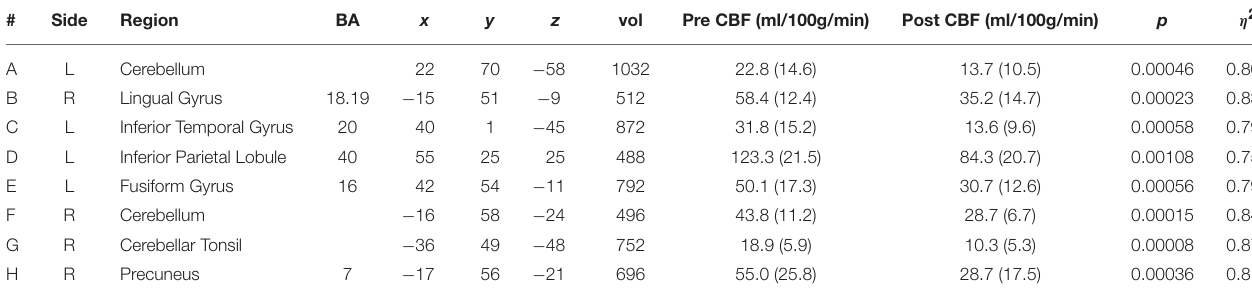
P-values and effect sizes reflect the change from baseline (pre) to after detraining (post) based on the average CBF within each ROI at each time point. η 2 , partial eta squared (effect size); # corresponds with regions shown in Figure 1 ; BA, Broadmann areas; LPI coordinates, positive, left (x), posterior (y), inferior (z); vol, volume in mm 3 ; CBF, cerebral blood flow